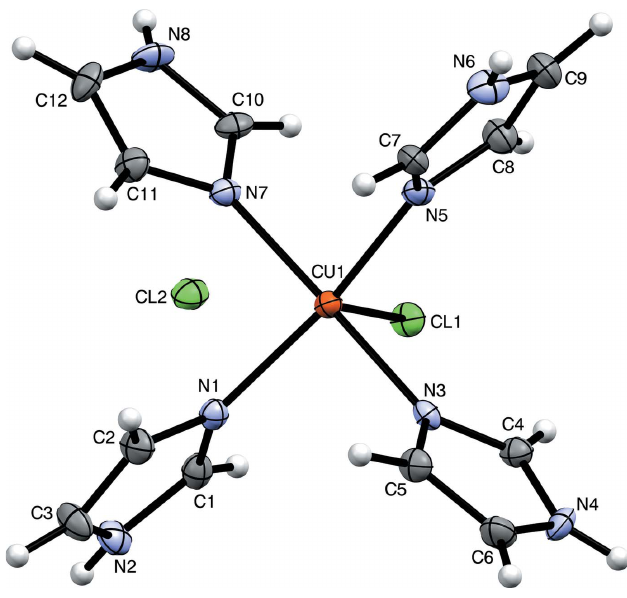
Figure 3 An ellipsoid plot of XUBNIR (50% probability), generated using Mercury (Macrae et al. ,